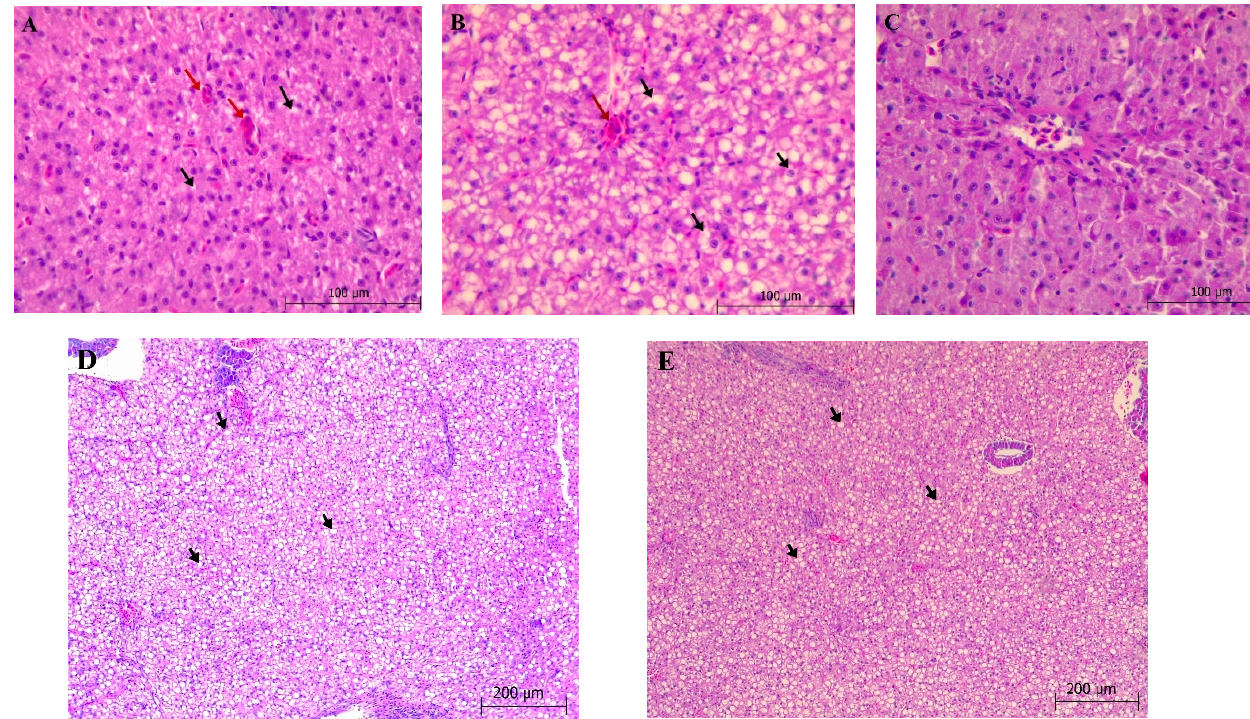
Figure 1. Histological preparations of livers (ematoxylin-eosin staining) of fingerling common carp after feeding exper- imental diets with graded levels of neroli oil (0–1.5%) for 60 days. ( A ) Degeneration of hepatocytes (black arrows) and congestion of sinusoids (red arrows) (N 0 ). ( B ) Hydropic degeneration (black arrows) and fat vacuoles in hepatocytes and congestion (red arrow) (NO 0.25 ). ( C ) Degeneration, fat vacuoles in hepatocytes and congestion (NO 0.50 ). ( D ) Hydropic de- generation and steatosis/lipid deposit in hepatocytes (black arrows) (NO 1 ). ( E ) Hepatocytes are hydropic and bubble-like degeneration, steatosis (black arrows) (NO 1.5 ).